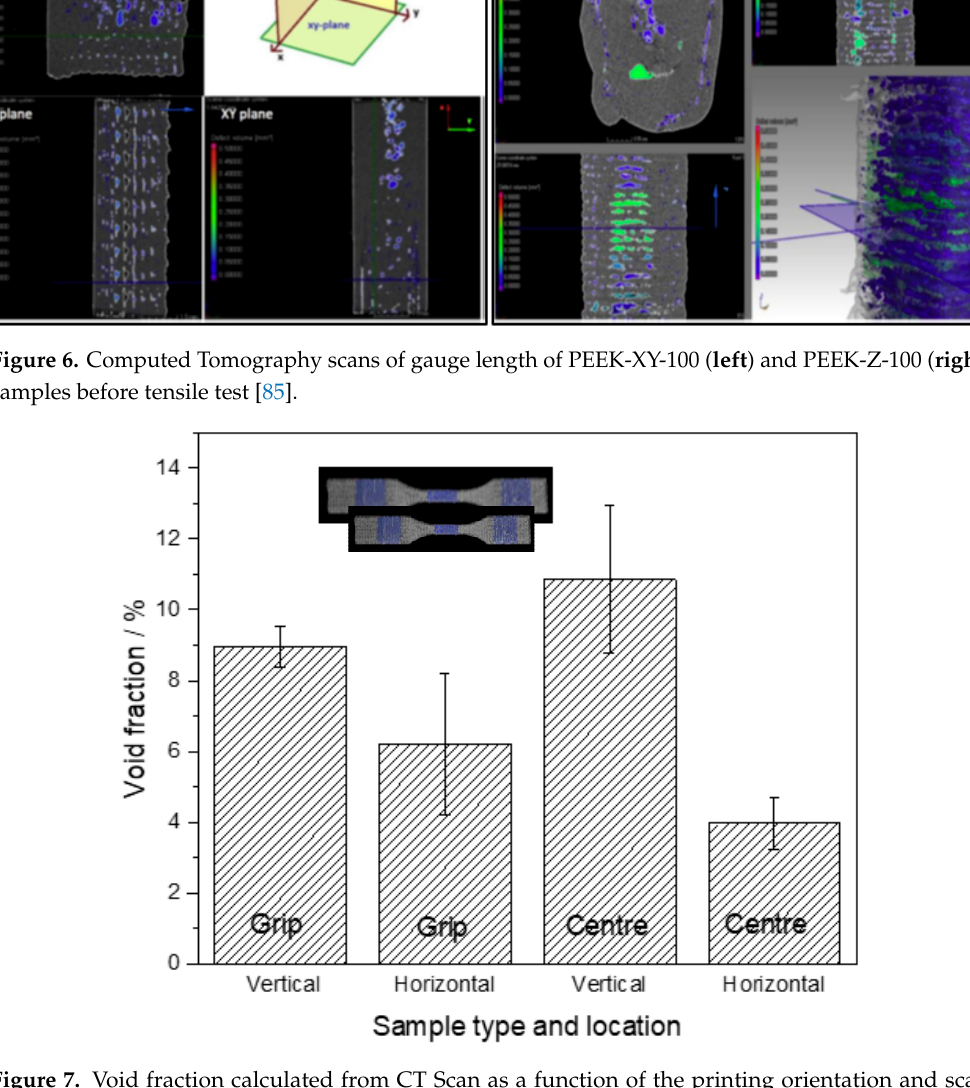
Figure 7. Void fraction calculated from CT Scan as a function of the printing orientation and scan location [106].